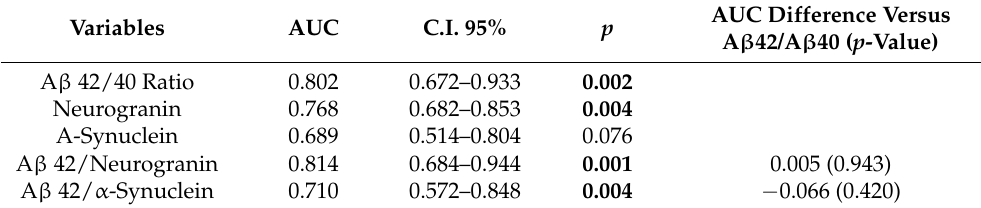
Table 3. ROC analyses of the CSF